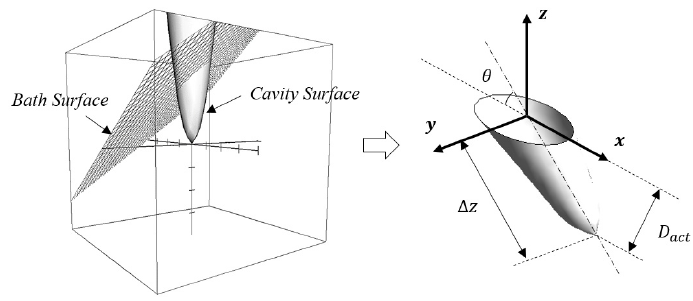
Figure 3. Sketch of 3D jet penetration cavity estimation.